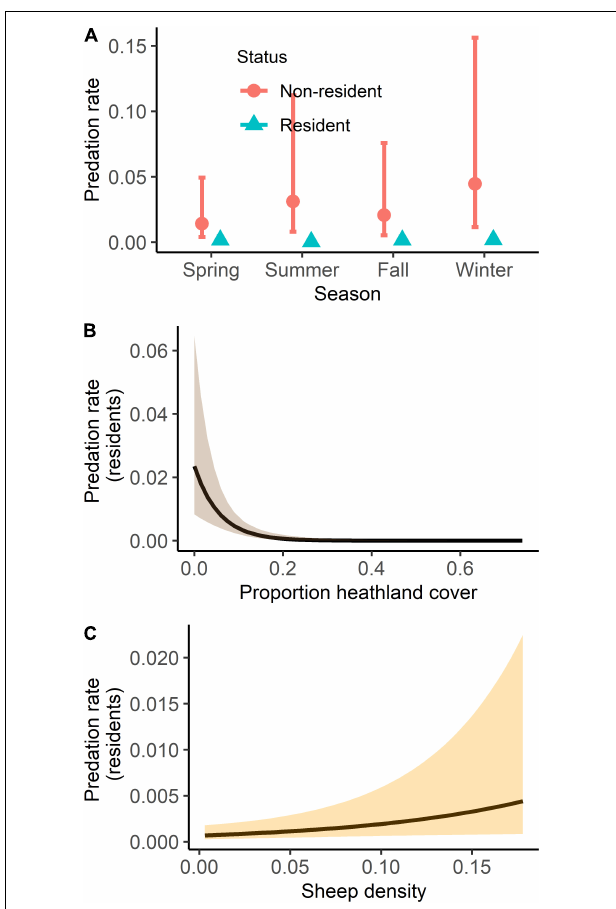
FIGURE 5 | Predicted probability of daily depredation events by individual wolves on livestock in relation to (A) season, shown separately for resident and non-resident wolves. Moreover, the predicted probability of daily depredation events by resident wolves on livestock in relation to the (B) proportion of heathland cover and (C) sheep density. Mean estimates are shown as dots (A) and lines (B,C) , and 95% confidence intervals as bars (A) and shading (B,C)